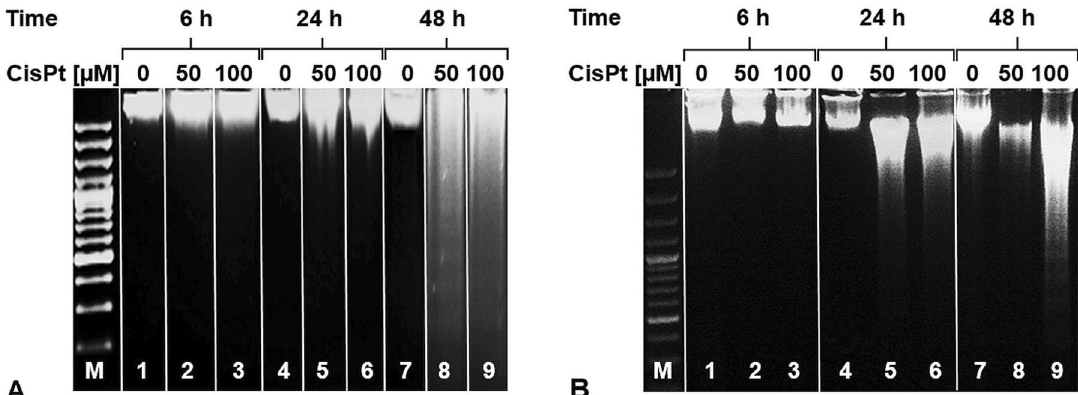
Figure 6. DNA ladder assay in CisPt treated cells. HepG2 ( A ) and HK-2 ( B ) cells were treated with CisPt (50 and 100 µM) for 6, 24 and 48 h. After DNA isolation, DNA ladder assay was performed. (0, untreated cells; 50,